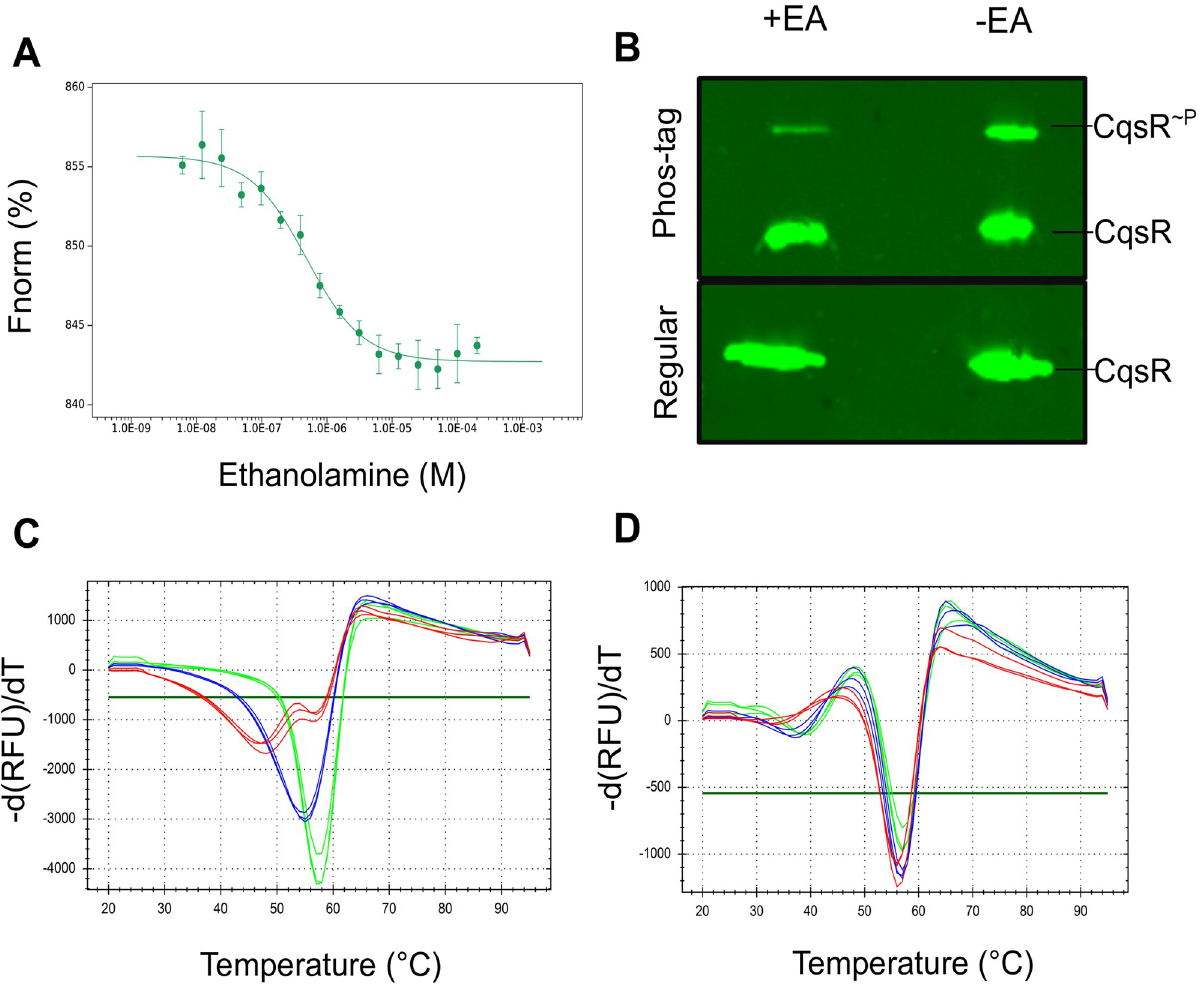
Fig 4. Characterization of ethanolamine binding to CqsR. (A) MST quantification (FNorm; normalized fluorescence) for ethanolamine binding to CqsR was performed by titrating between 200 μ M and 0.0061 μ M with 20 nM His6-tagged CqsR. Ethanolamine binds to CqsR with a Kd of 0.478 ± 0.076 μ M. Binding affinity was calculated from three independent experiments. B) Immunoblots of CqsR using Phos-tag (top) and regular gels (bottom). The singly phosphorylated CqsR runs as a distinct band at a higher molecular weight compared to the unphosphorylated CqsR with a Phos- tag gel. The ratio of phosphorylated to unphosphorylated forms of CqsR is substantially lower in the presence of 10 mM ethanolamine. Differential scanning fluorimetry melt curves of purified C) MBP-CqsR-LBD and D) MBP-CqsR D171V -LBD in the presence of 0 μ M (red), 20 μ M (blue), 200 μ M (green) ethanolamine. A positive shift in Tm of MBP-CqsR-LBD indicates ligand binding, while no shift is observed for MBP-CqsR D171V -LBD in the presence of ethanolamine.